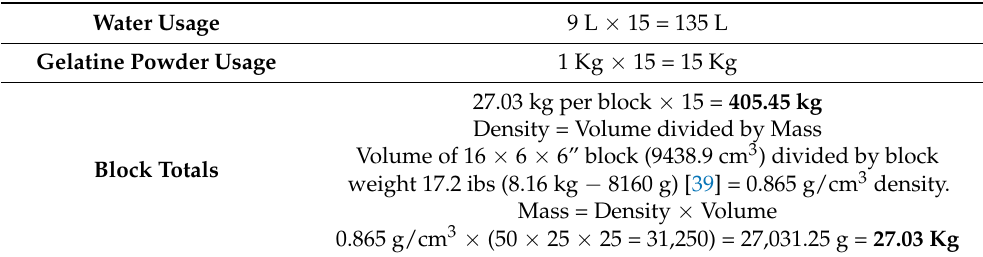
Table 2. Gelatine waste generation from survivability assessment scenario.